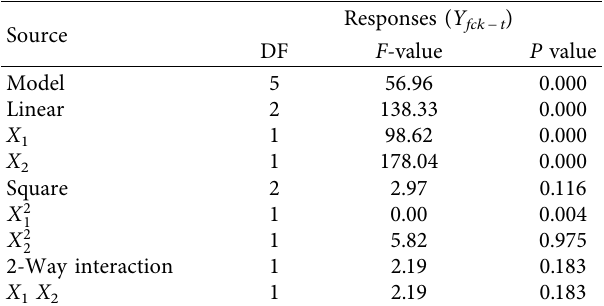
Figure 4: Comparison of the effects of the D/t ratio and concrete strength on the ultimate strength of a column. Table 3: Regression model’s analysis of variance (ANOVA) for experimental outcomes.